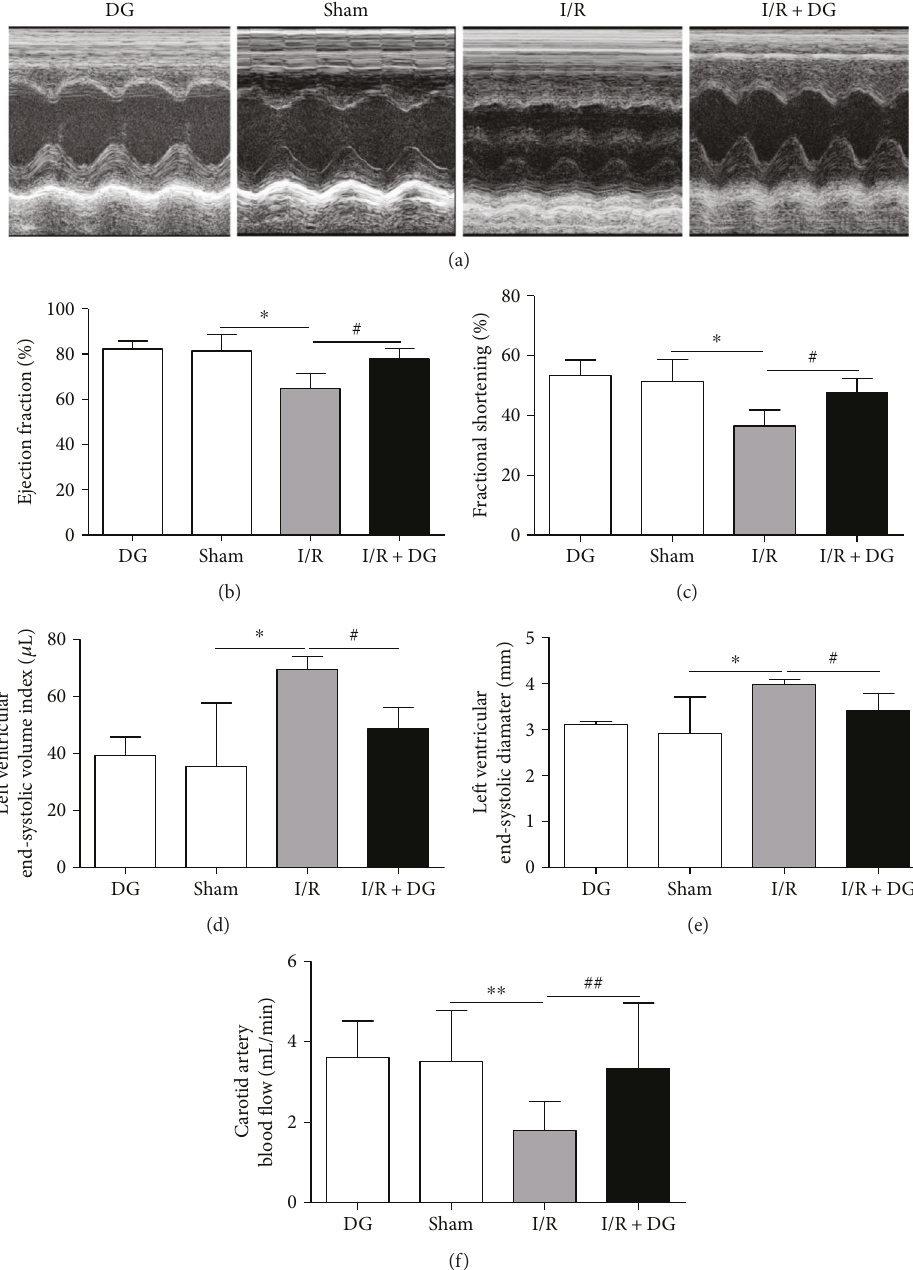
Figure 3: Dunye Guanxinning improved cardiac function. (a) Typical left ventricular echocardiography in rats; (b – e) LVEF, fractional shortening, end-systolic volume index, and end-systolic diameter were determined using a Vevo 770 high-resolution imaging system to measure cardiac function ( n = 3 ); (f) carotid arterial blood fl ow was tested using a PowerLab 8-channel multifunctional recorder ( n = 10 ). Data are expressed as mean ± SD. ∗ P < 0 05 or ∗∗ P < 0 01 versus sham operation group; # P < 0 05 or ## P < 0 01 versus ischemia- reperfusion